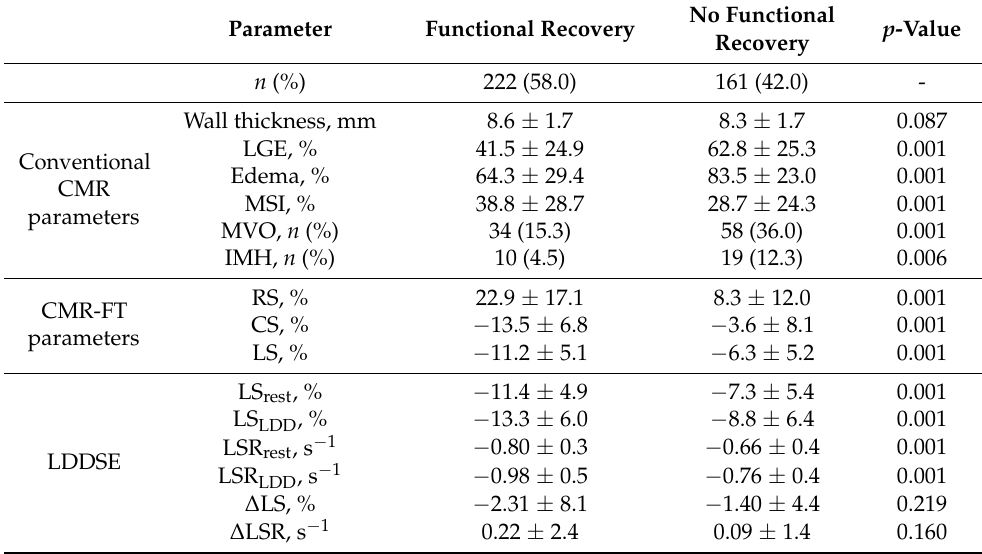
Table 2. CMR and LDDSE parameters according to functional recovery at 6-months.